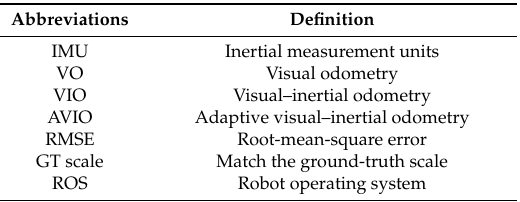
Table 1. Table of abbreviations.